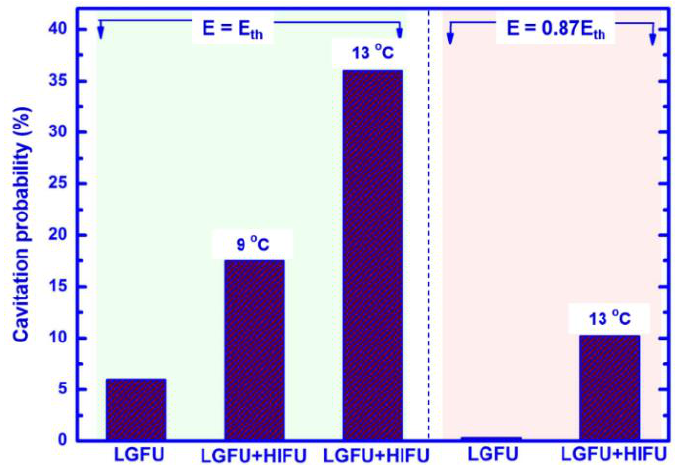
Figure 7. Cavitation occurrence due to the input laser energies of 4.35 mJ/pulse and 3.78 mJ/pulse. Based on the feasibility of thermal enhancement of LGFU-induced cavitation, we employed a stacked hybrid transmitter for standalone operation of two FUS from a single- shared curvature. The time–domain waveforms from the hybrid transmitter were acquired at the focal zone. Figure 8a illustrates the bipolar LGFU waveform at ~12 µ s (i.e., corre- sponding to the radius of curvature (~18 mm)) obtained solely by pulsed-laser irradiation (10 mJ/pulse) without turning on the HIFU transmitter. The ringing effect after the LGFU pulse resulted from the backing substrate including the piezoelectric layer. Similarly, the HIFU waveform (20% duty cycle) without LGFU (no laser irradiation) was measured in the same manner (Figure 8b). The maximum pressure amplitude for HIFU was also obtained at ~12 µ s. Then, the transmitter surface was irradiated with the pulsed-laser beam together with the application of an amplified sinusoidal waveform for HIFU. Figure 8c illustrates the time–domain waveform generated by the spatio-temporal superposition of LGFU and HIFU turned on simultaneously.